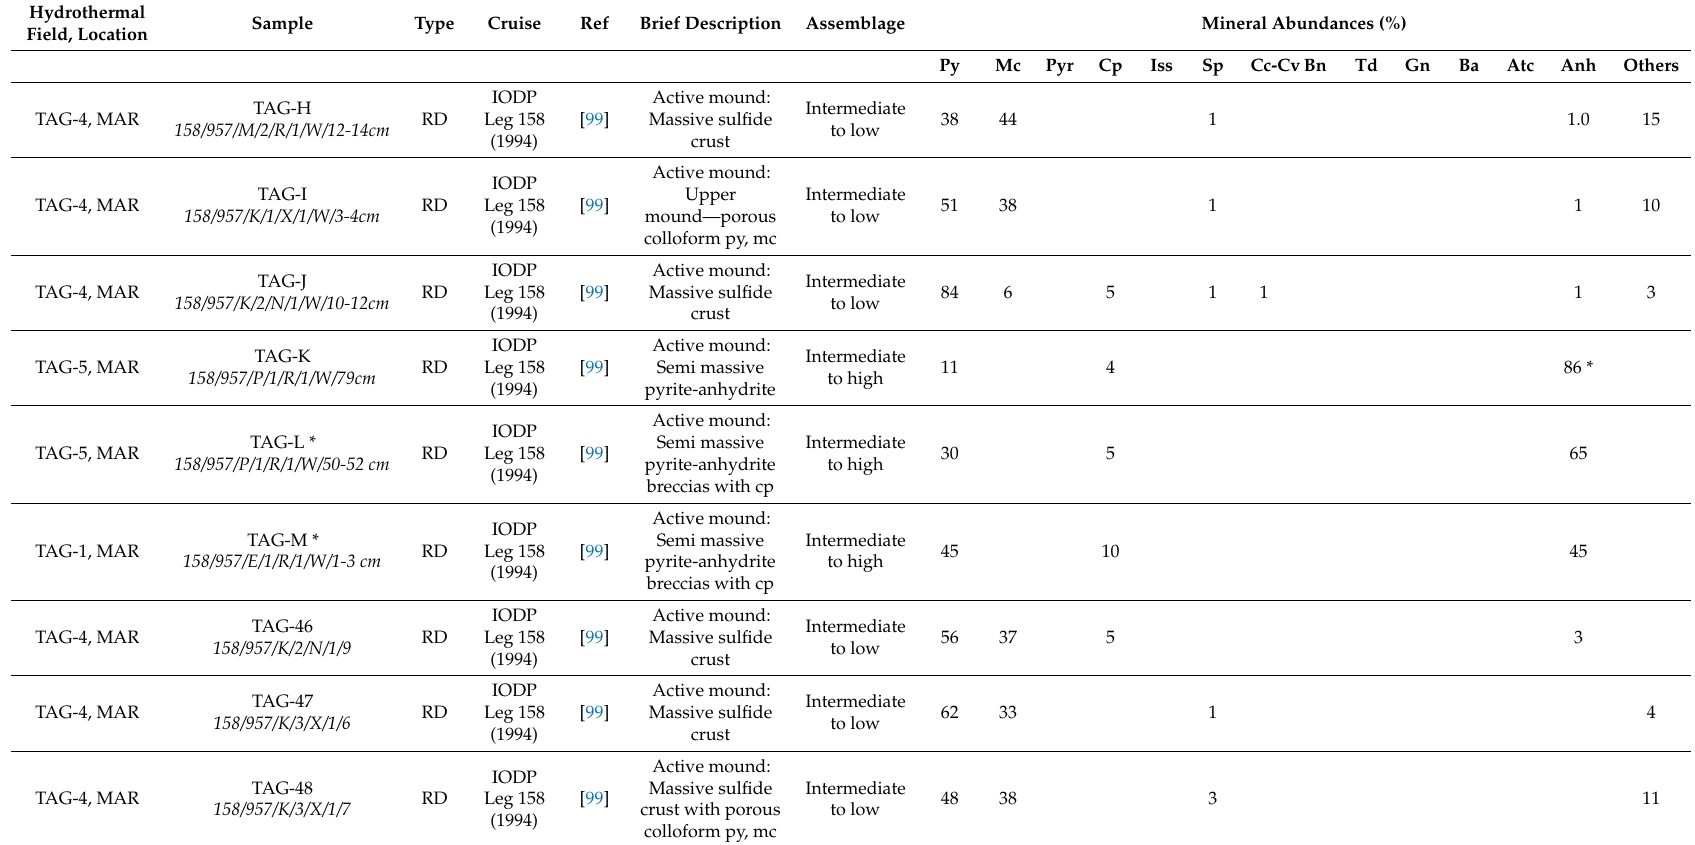
Table 4. Sulfide samples used throughout this study, quoted with their semi quantitative mineral abundances calculated from powder X-ray diffraction (XRD) data where available. Where not available, mineral abundances have been estimated through reflected light microscopy and SEM analysis. Abbreviations used in this table are tr (trace), py (pyrite), mc (marcasite), pyr (pyrrhotite), cp (chalcopyrite), is (isocubanite), sp (sphalerite), cc-cv (chalcocite-covellite), bn (bornite), td (tennantite-tetrahedrite), gn (galena), ba (barite), atc (atacamite) and anh (anhydrite). “Others” include quartz, silicates, carbonate, jarosite, native sulfur and Fe